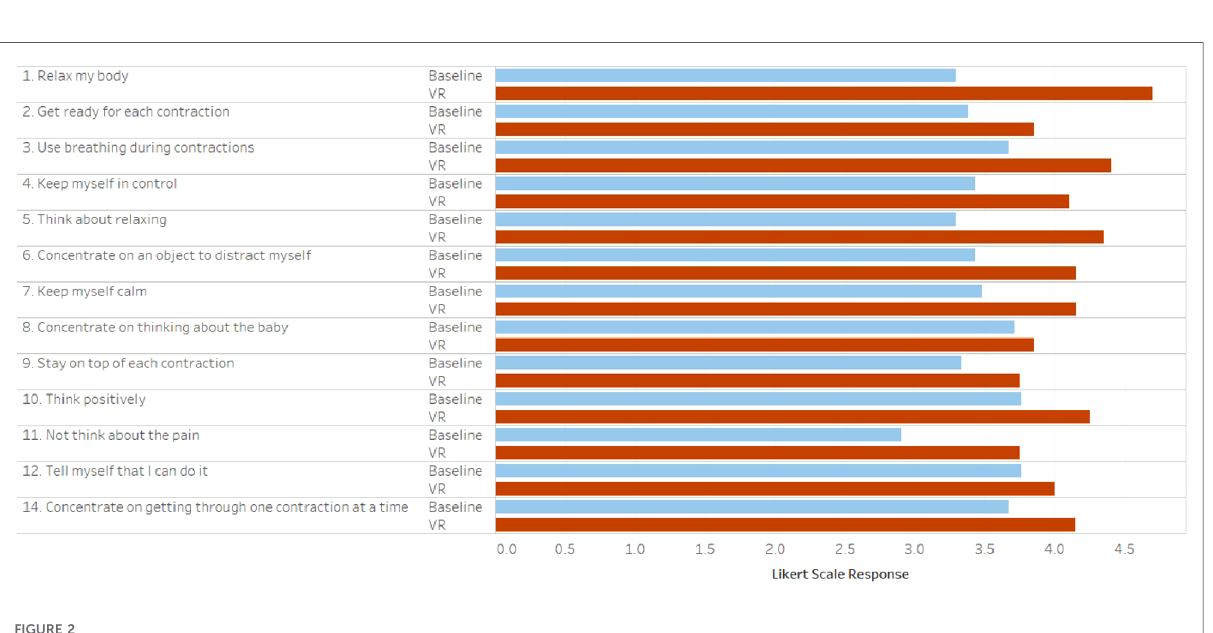
FIGURE 2 Baseline and post-VR childbirth self-ef fi cacy indices. All individual values and adjused sum totals were statistically signi fi cantly improved in the VR